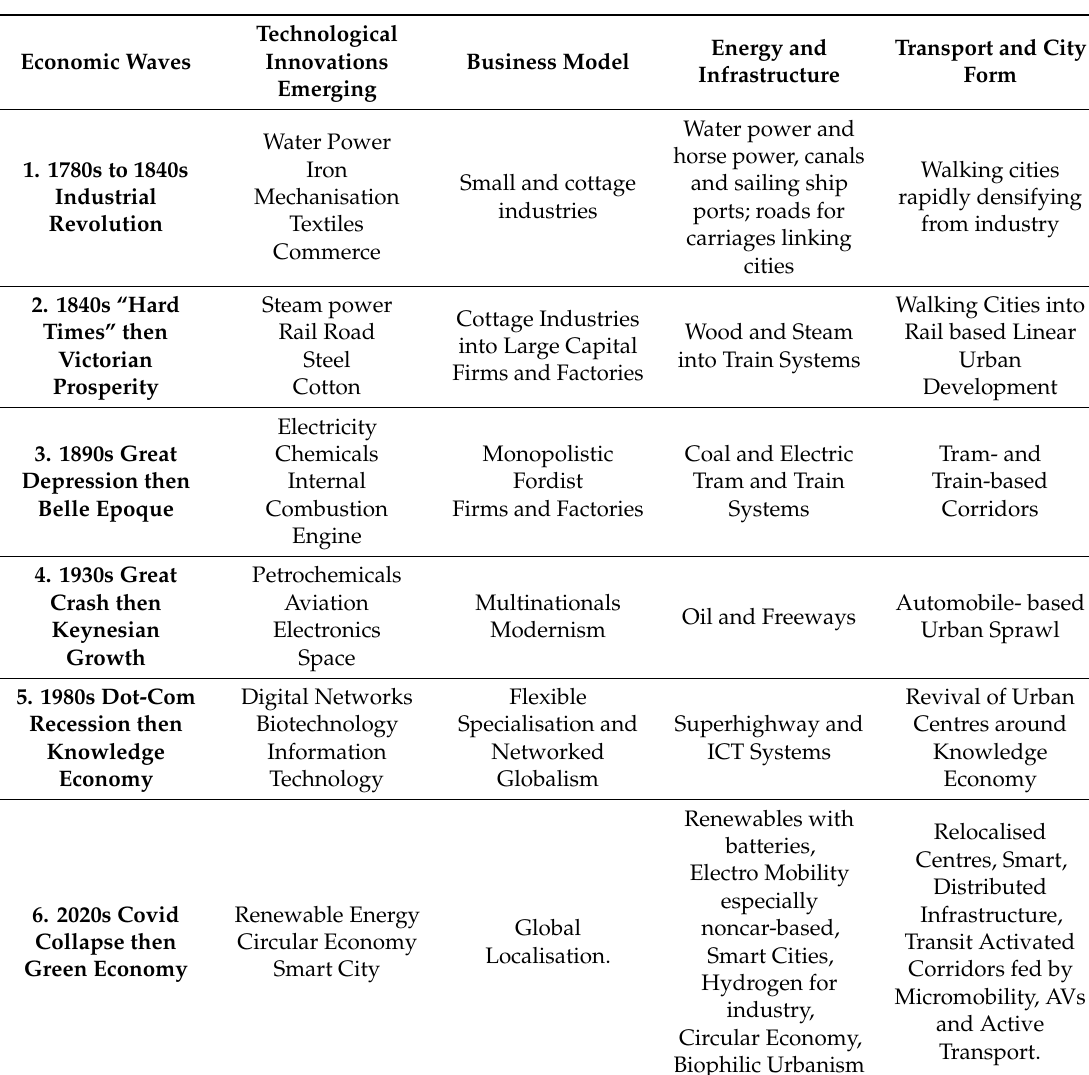
Table 1. The waves of innovation following economic collapse in the past 250 years and what they meant for business models, energy and infrastructure, transport and urban form, with potential options for the next